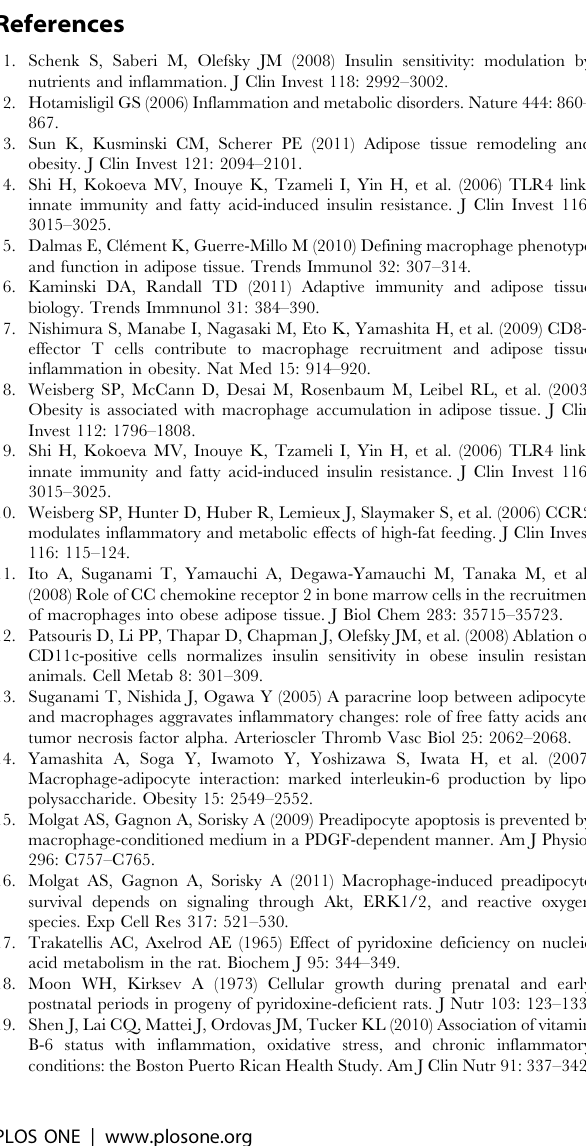
Table S1 Effect of dietary level of vitamin B6 (pyridox- ine HCl) on tissue concentration of pyridoxal 5 9 - phosphate (PLP) in mice fed 20% corn oil diet. Values represent means 6 S.E. (n= 4). ** p , 0.05 compared with that of 1 mg/kg vitamin B6. Table S2 Body weight, food intake and adipose tissue weight. Values represent means 6 S.E. (n